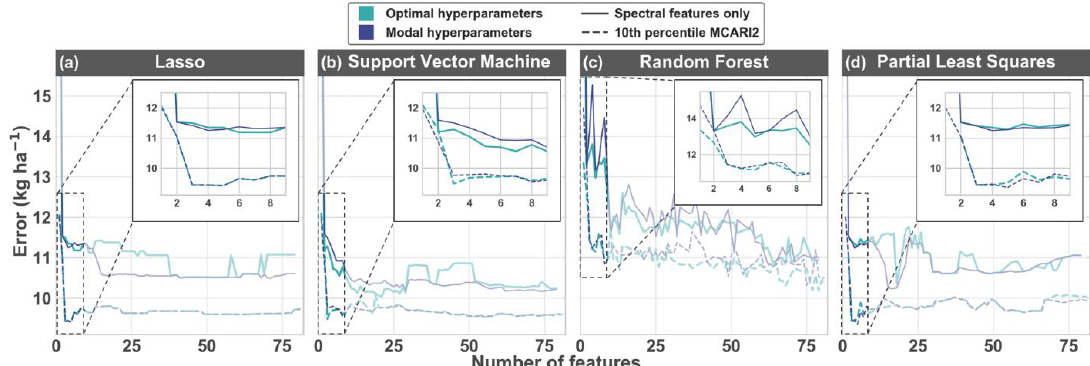
Figure 8. Influence of feature number on the mean absolute error (MAE) of the test dataset for Lasso ( a ), support vector regression ( b ), random forest ( c ), and partial least squares ( d ) models. The error designated by optimal hyperparameters indicates that the model hyperparameters were adjusted for each input feature number based on the results of the hyperparameter tuning, and the error designated by modal hyperparameters indicates that the hyperparameters were fixed for all number of features. Errors are presented for models that used spectral features only (solid lines), as well as well as for models that used the 10th percentile MCARI2 (Modified Chlorophyll Absorption Ratio Index Improved) auxiliary feature in addition to spectral features (dashed lines).